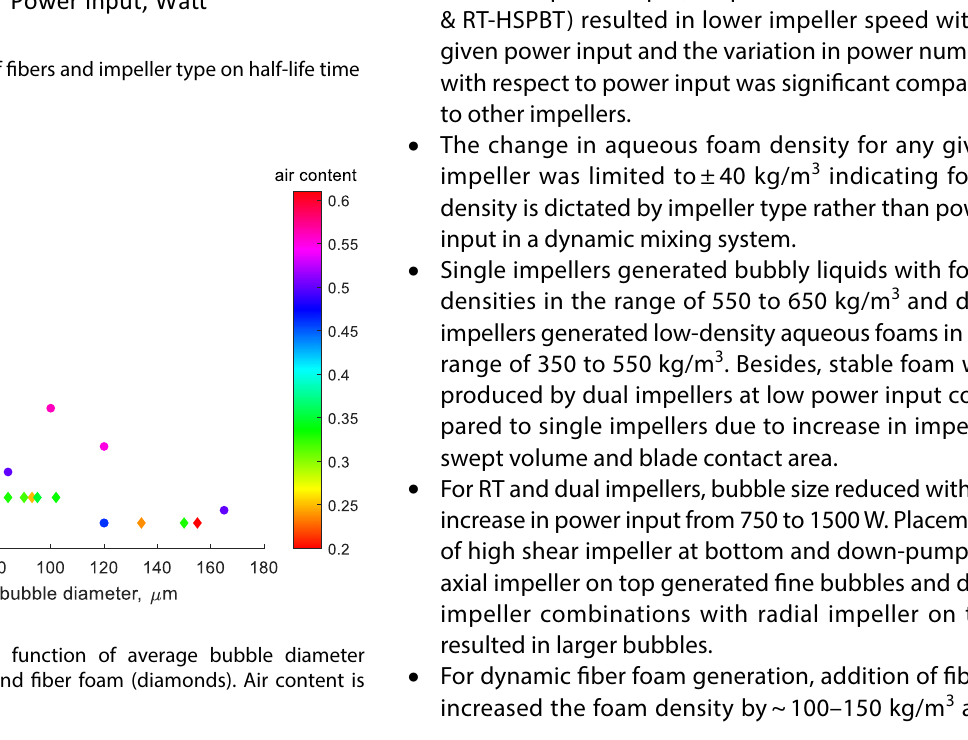
Table 2 Summary of the performance of the impeller for dynamic foam generation (average over the power range of 1500–2250